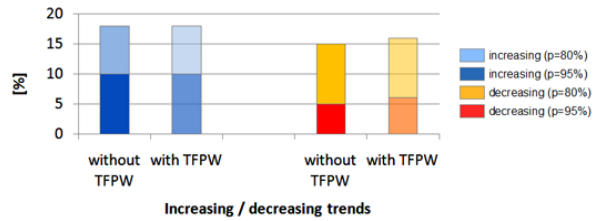
Fig. 2. Total percentage of increasing and decreasing trends in the 171 time series of all 3 runoff indicators (mean, high, low) and all 3 time frames (hydrological year, winter, summer); significant trend: p = 80%; highly significant trend: p = 95%; difference of trend results without prior removal of significant autocorrelation by trend- free-pre-whitening (TFPW) and with